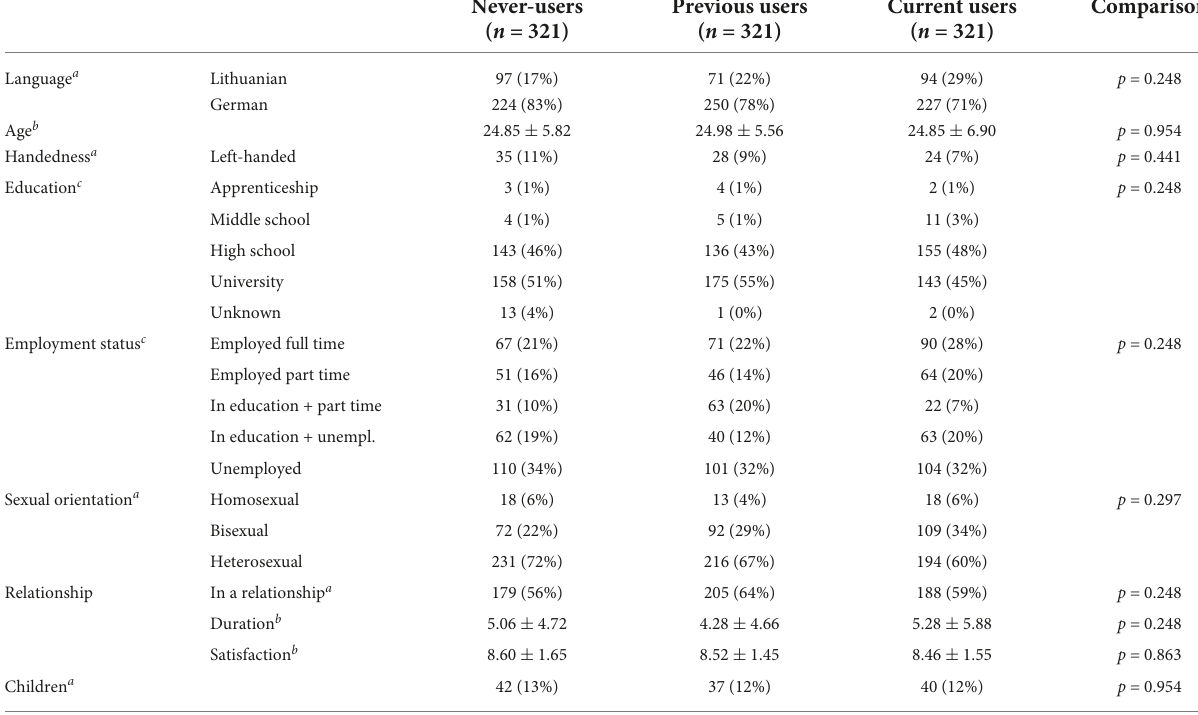
TABLE 2 Comparison of demographic variables between current and previous HC-users and never users matched for age, language, sexual orientation, and relationship status.